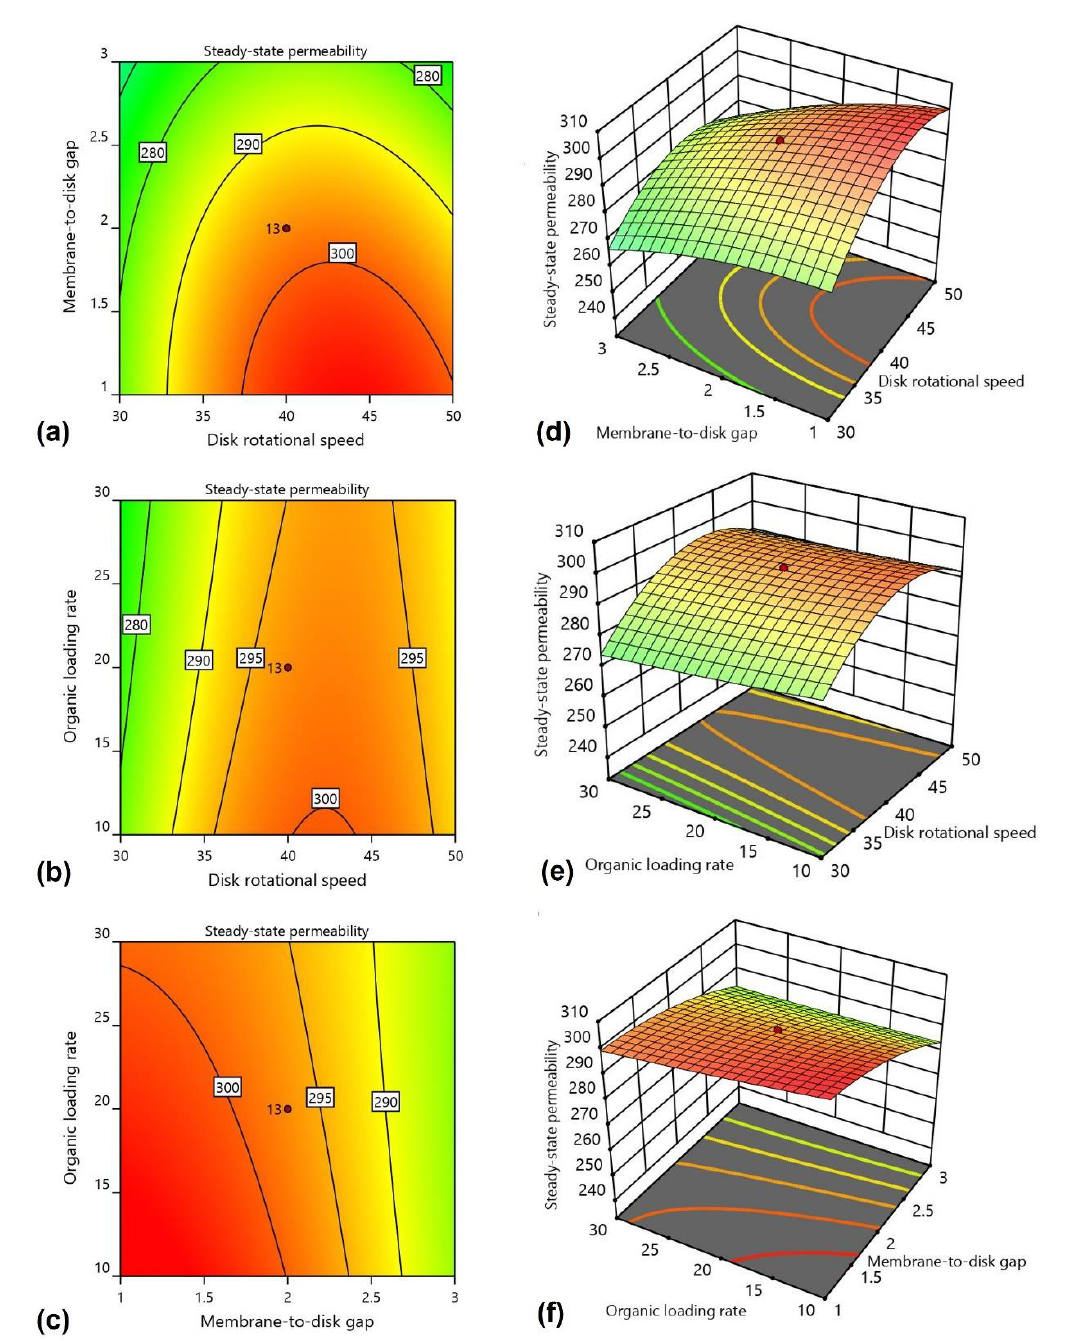
Figure 4. Effect on 2-D contours of ( a ) disk rotational speed and membrane-to-disk gap, ( b ) disk rotational speed and organic loading rate, and ( c ) membrane-to-disk gap and organic loading rate; and 3-D response surface plots of ( d ) disk rotational speed and membrane-to-disk gap, ( e ) disk rotational speed and organic loading rate, and ( f ) membrane-to-disk gap and organic loading rate. Figure 4a,d demonstrate the effects of disk rotational speed and membrane-to-disk gap on the permeability. In these conditions, the organic loading rate was kept constant at 20 g COD/m 2 d. The results demonstrate that with the increase to disk rotational speed, permeability increases because higher shear is generated with increased speed, which re- moves the deposited foulants from the membrane surface. However, it can be seen from the figures that, after 45 rpm, the value of permeability decreases. The decline in